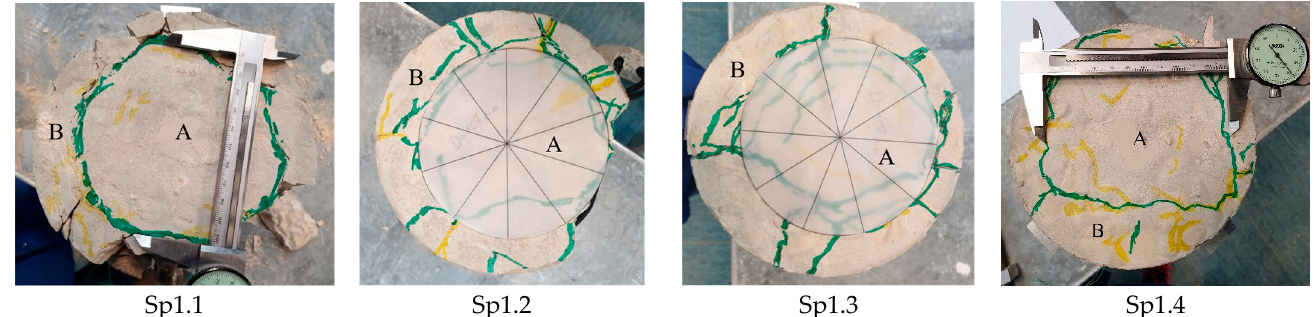
Figure 11. Failure pattern of the upper surface of the specimens.